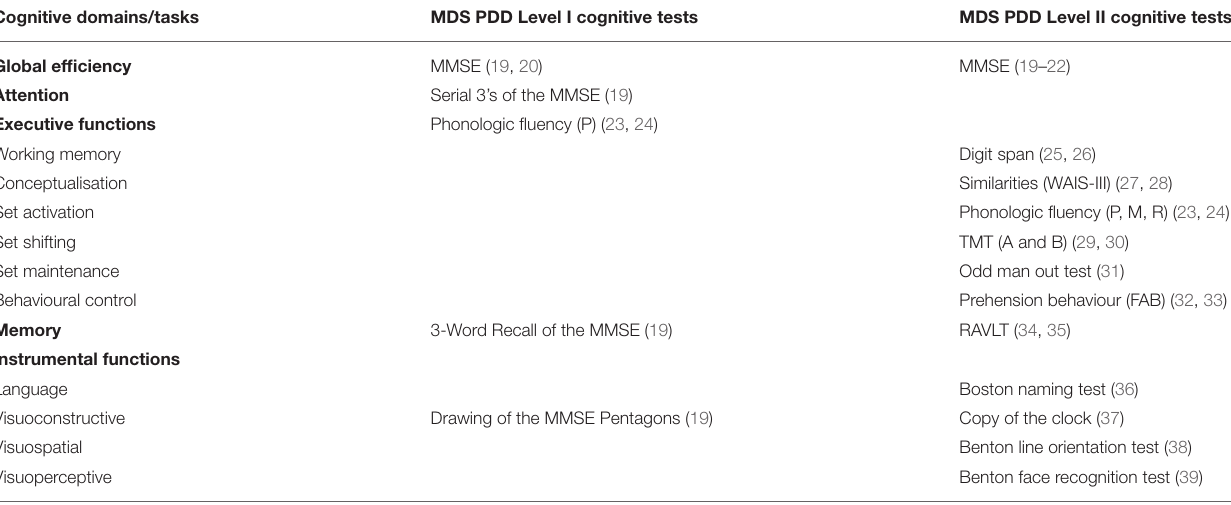
TABLE 1 | Neuropsychological tests used to assess cognition according to MDS PDD Level I and Level II